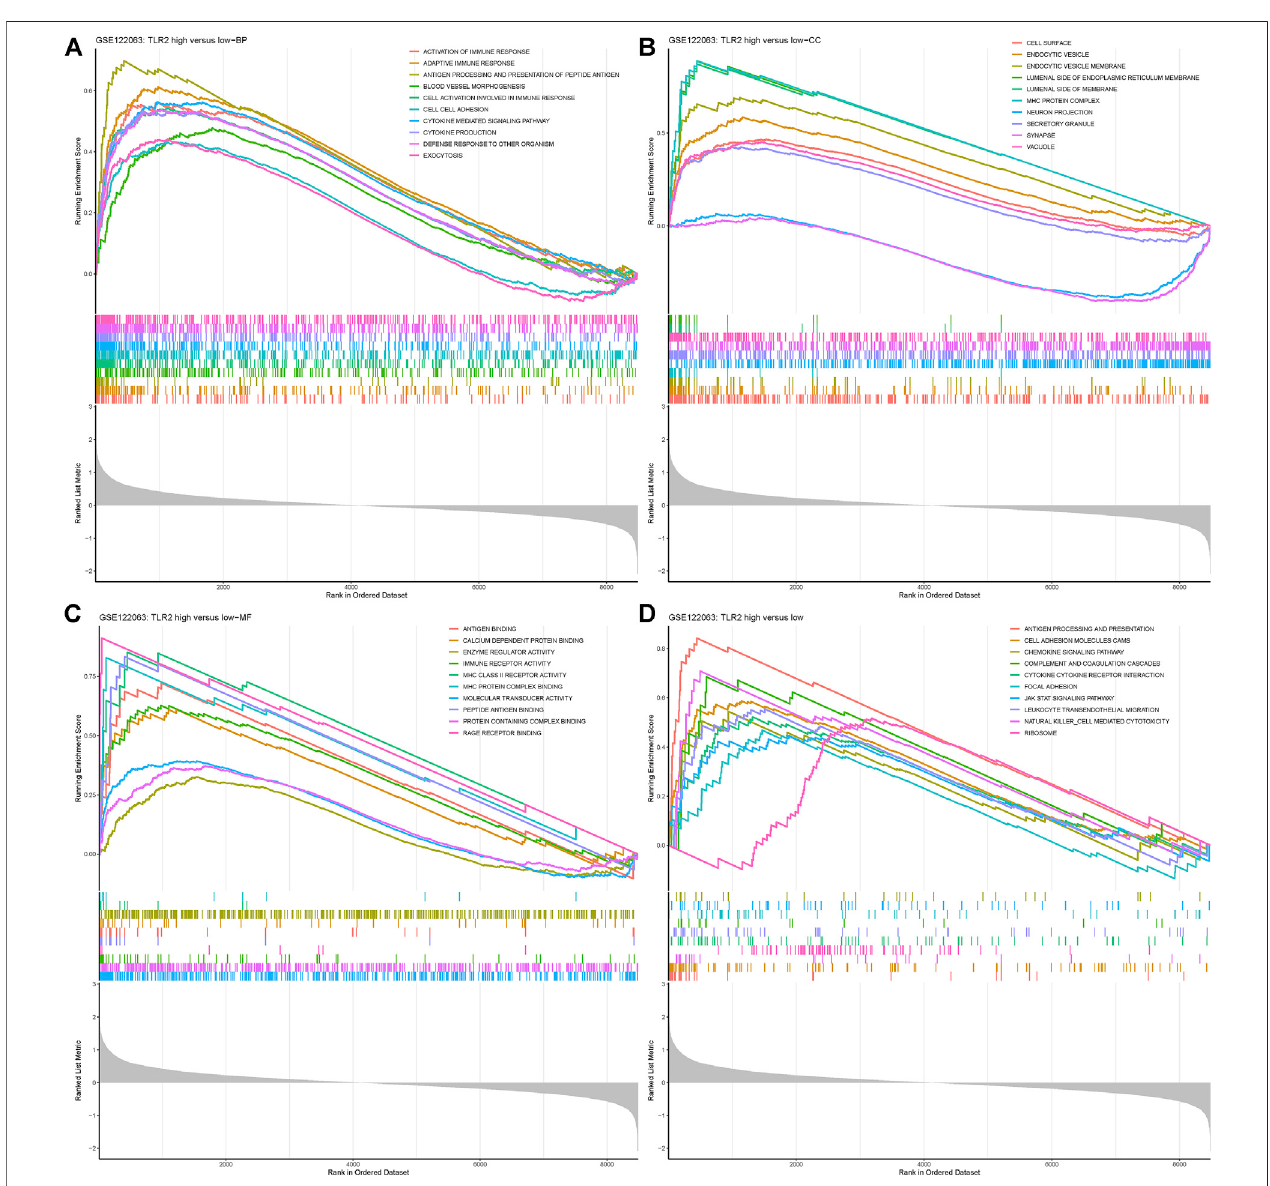
FIGURE5| GeneSet EnrichmentAnalysis(GSEA)results grouped bytheexpression levelofTLR2. (A) BPenriched inTLR2-high group. (B) CC enriched inTLR2- high group. (C) MF enriched in TLR2-high group. (D) KEGG pathways enriched in TLR2-high group.